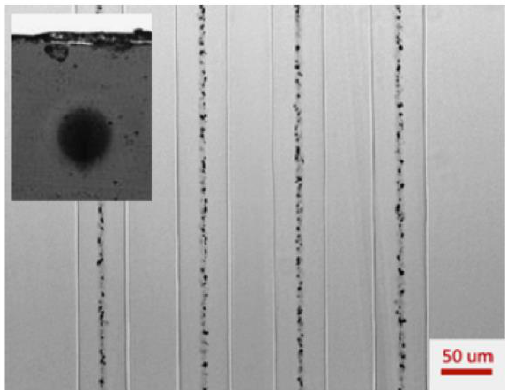
Figure 2. Optical microscopy image of waveguides produced with an energy of 42 nJ and scanning speed of 100 μm/s. The inset shows a transverse image of a typical waveguide. Reprinted with permission from [51]. Copyright (2014) Elsevier.